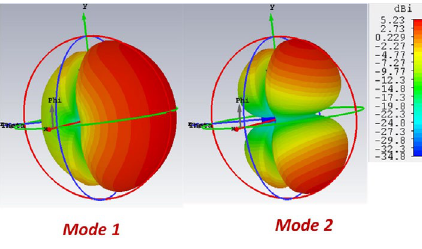
Figure 5. CMA of proposed tag antenna above liquid filled plastic water